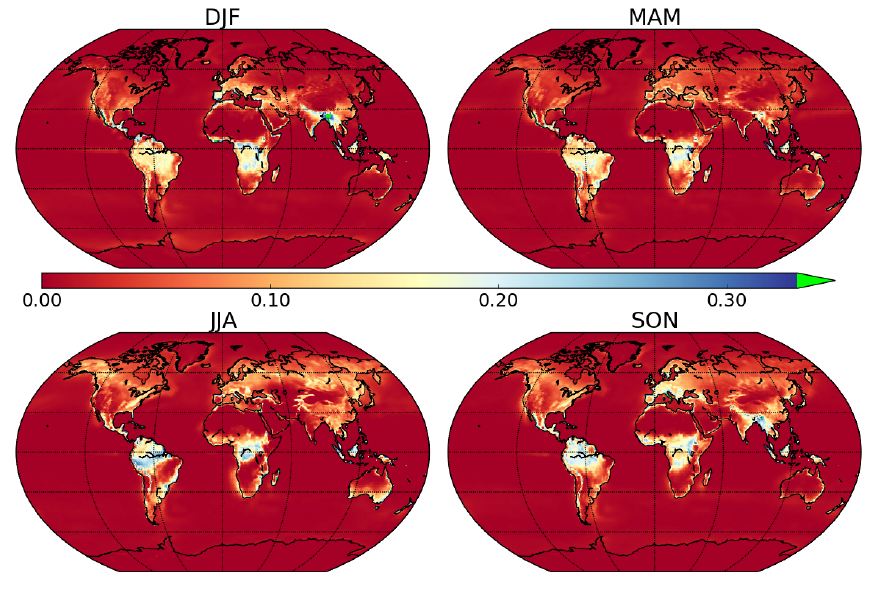
Figure 6. Mean seasonal formation of dew (mmd − 1 ).